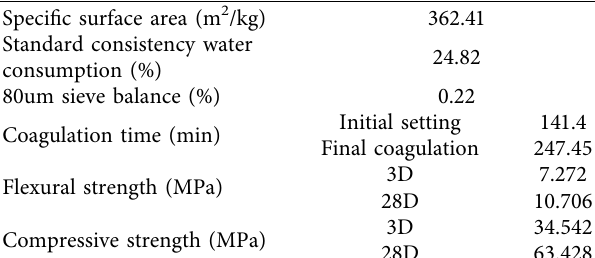
Table 3: Basic physical properties of cement.